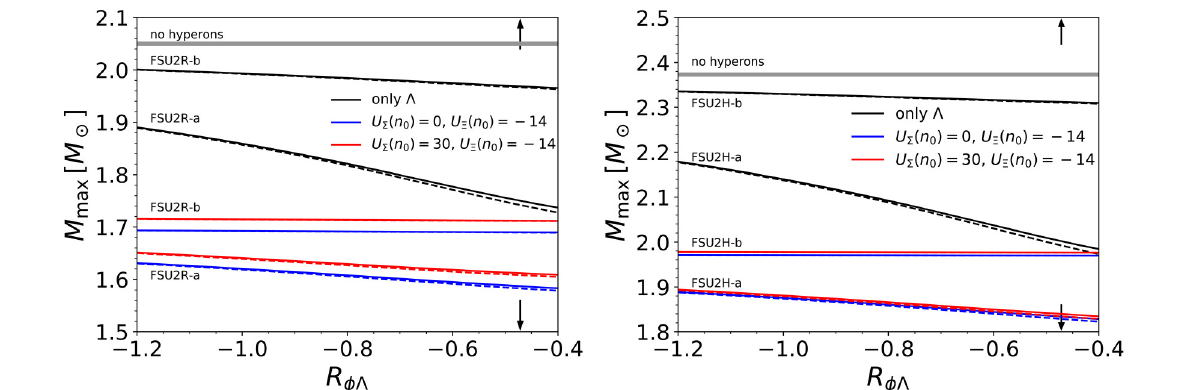
In Figure 1 predictions for two limiting scenarios are plotted: (a) the EoSs defining the minimal hyperonic model include only the 3 hyperons in addition to the nucleons (black lines). These models may be considered to set an upper limit on the maximum mass of an hyperonic NS, because adding other degrees of freedom will soften the EoS; (b) the EoSs designated as maximal hyperonic models include the full baryonic octet (colored lines). An estimation of the lower limits for the maximum mass of hyperonic NSs is obtained not including the mesons that account for the YY interaction. The blue stripped areas in Figure 2 correspond, precisely, to the mass range covered when employing the minimal hyperonic models and the maximal hyperonic models with U 6 ( n 0 ) 0 MeV = and U 4 ( n 0 ) 14 MeV, taking the SU (6) values of the = − coupling constants R ω3 and R φ3 for both sets of models and also the SU (6) value of the coupling constant R ω6 in the maximal hyperonic